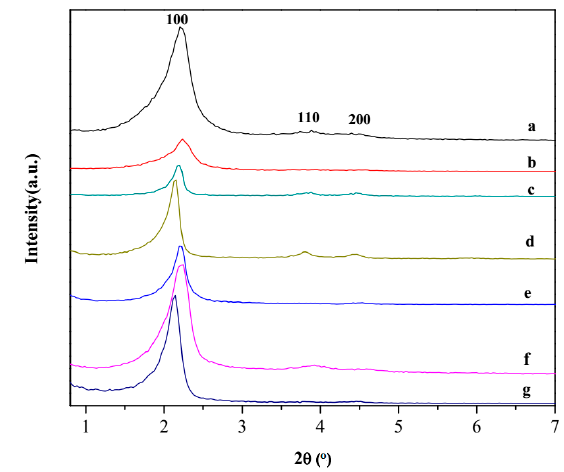
Figure 1. Low angle XRD patterns of (a) MSNs and FMSNs includes the following: (b) MSN-Et 3 N- IPTMS-hpbtz- f1 , (c) MSN-pyridine-IPTMS-hpbtz- f2 , (d) MSN-NaOH-IPTMS-hpbtz- f3 , (e) MSN- Et 3 N-NCO-hpbtz- e1 , (f) MSN-pyridine-NCO-hpbtz- e2, and (g) MSN-NaOH-NCO-hpbtz- e3